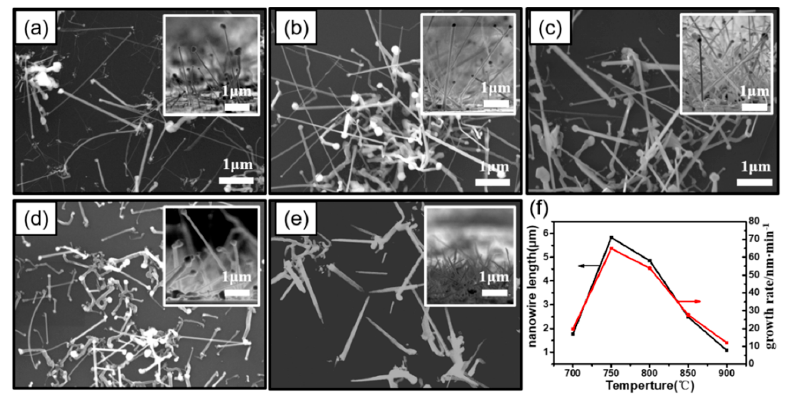
Figure 1. SEM surface images of Ga 2 O 3 NWs grown at various temperatures. ( a ) 700 °C, ( b ) 750 °C, ( c ) 800 °C, ( d ) 850 °C, ( e ) 900 °C, and ( f ) relationship between the length and growth rate of NWs and growth temperature. Inset of ( a – e ) are magnified cross-sectional SEM images illustrating the length of the NWs. From NWs growth speed, 750 to 800 °C is a promising temperature.